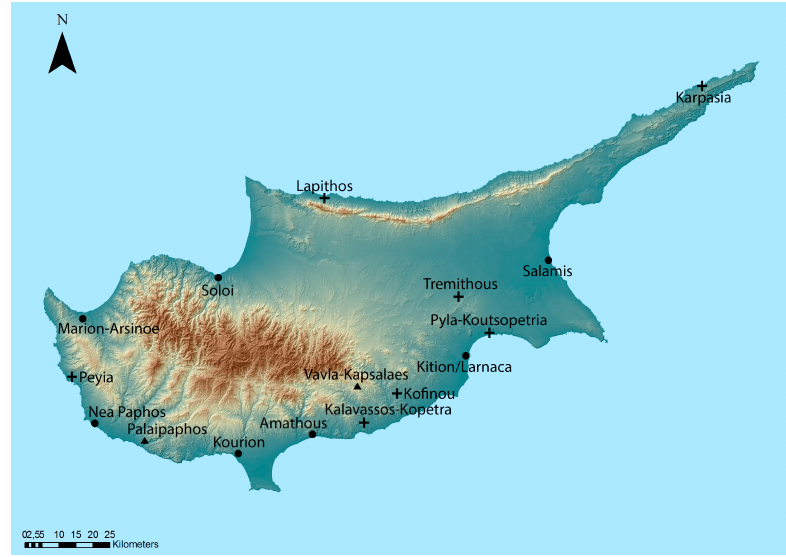
Figure 1. Map of Cyprus with places and archaeological sites mentioned in the text. Circle: ancient city; triangle: ancient cult-site; cross: Christian site (digital geological data courtesy of the Geological Survey Department, Republic of Cyprus; map drafted by A.K. Vionis).